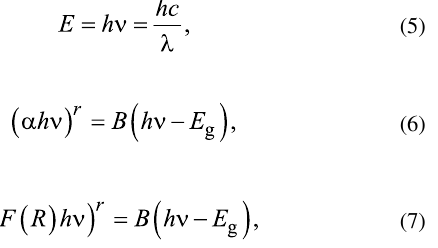
lamp (300 W) for 30